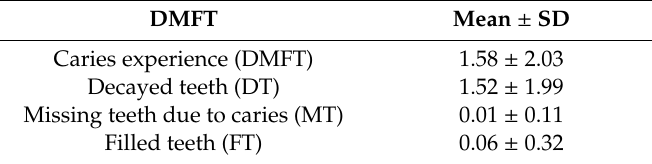
Table1. CariesexperiencemeasuredbyDecayed, Missing(duetocaries),